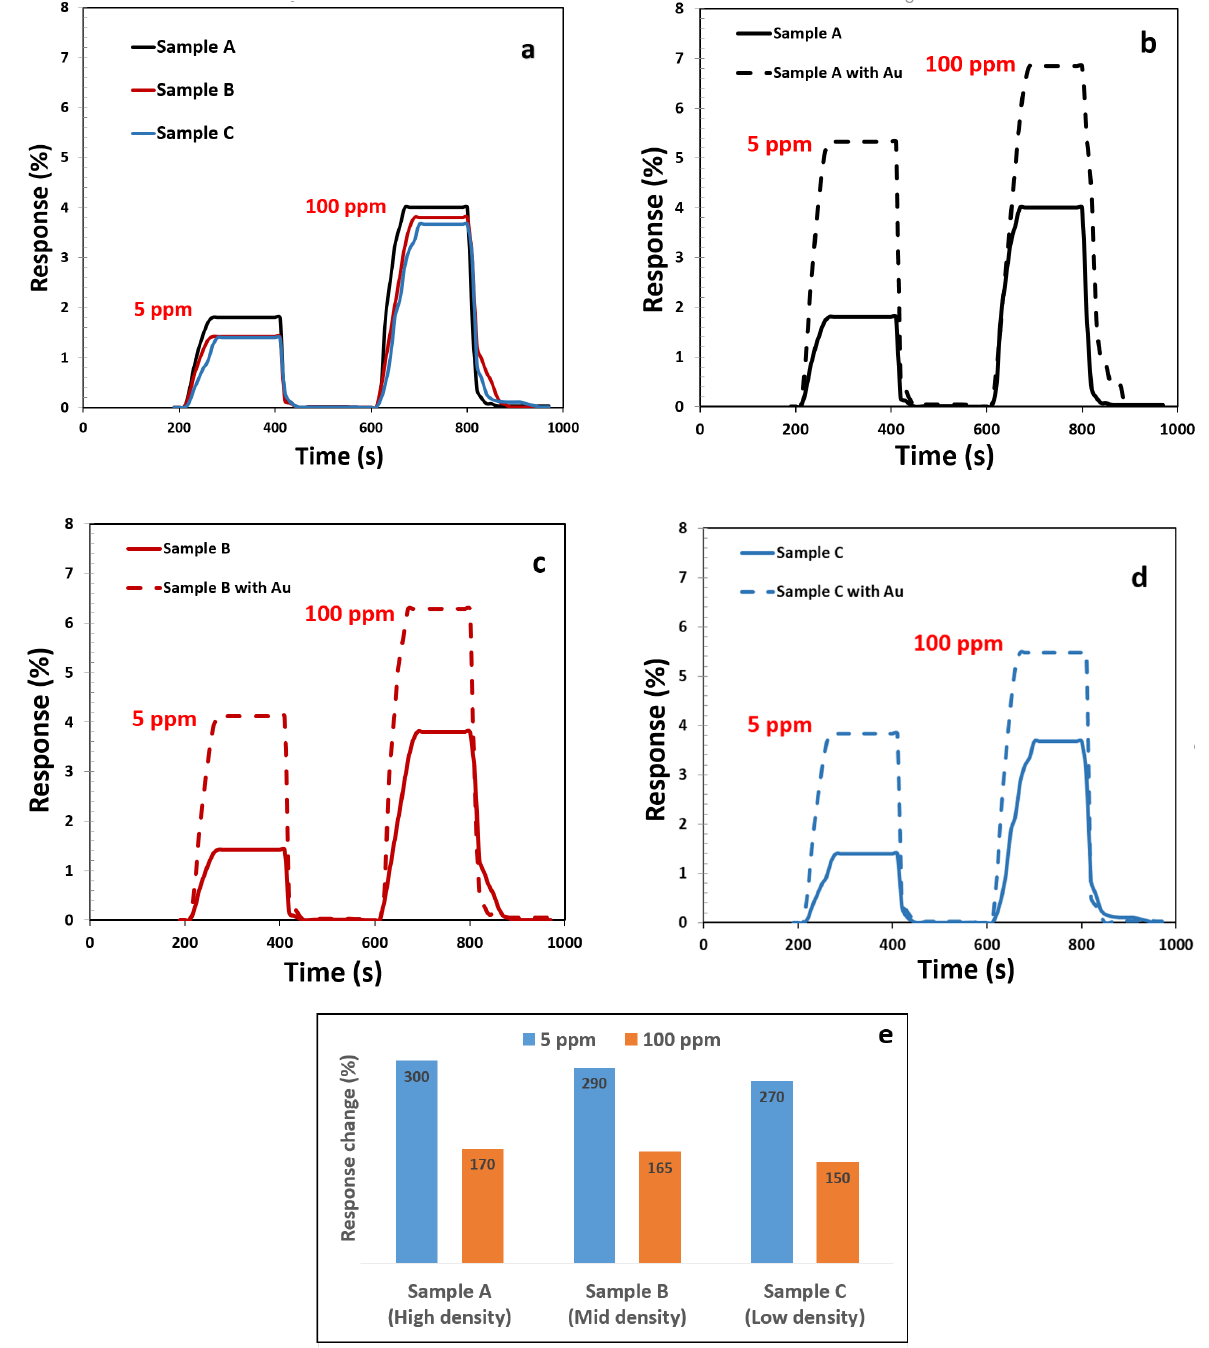
Figure 7. ( a – d ) Response of CNF and decorated at different concentrations of ethanol vapor at room temperature. ( e ) Percentage of response changes after decorated with gold.